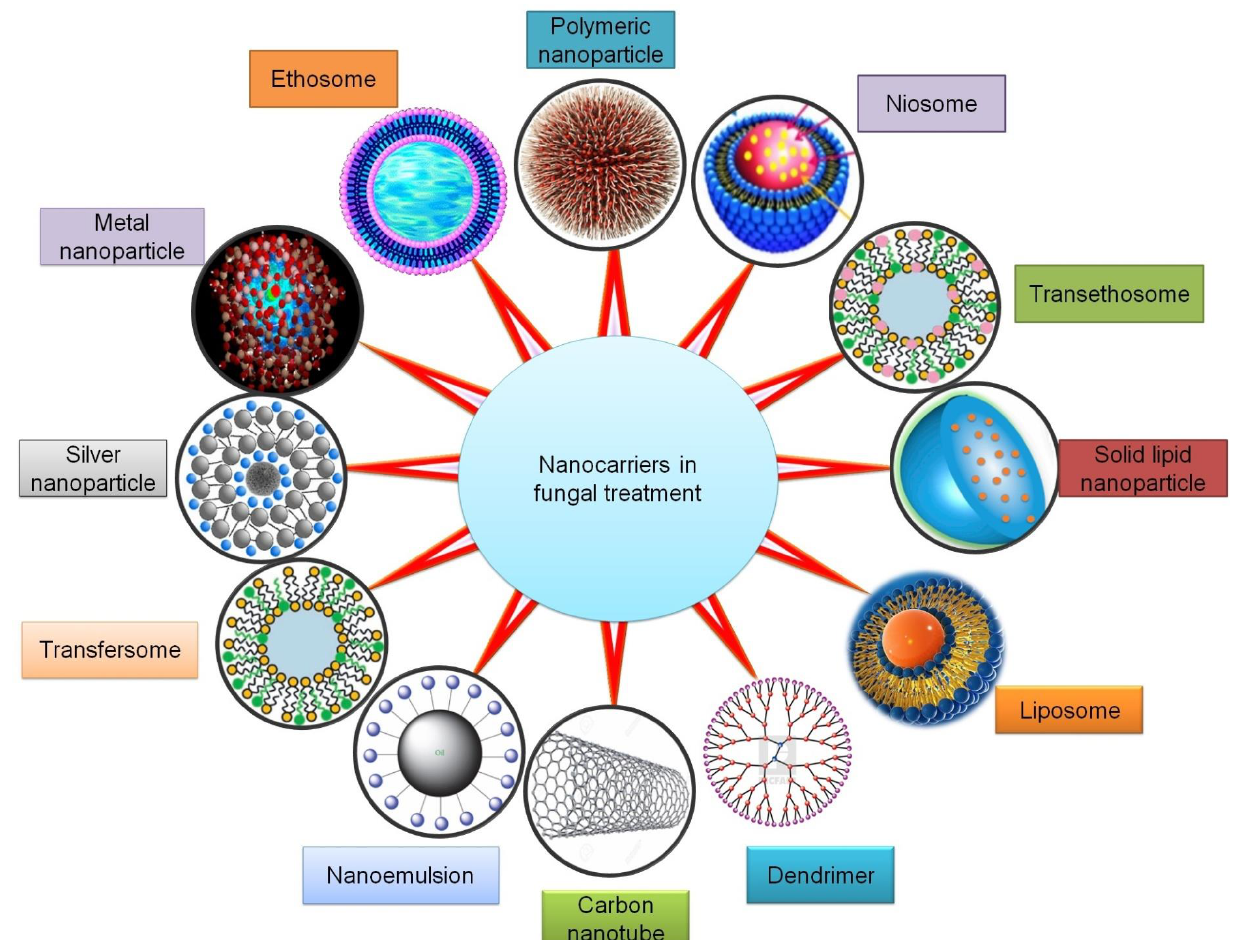
Figure 2. Nanocarriers that can improve therapeutic outcomes in the management of fungal infections.